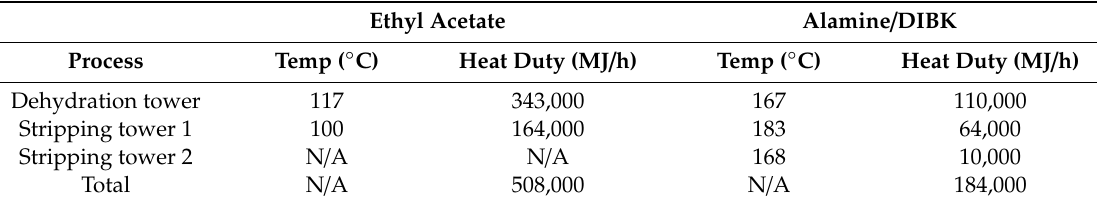
Table 2. Temperature and energy consumption for liquid–liquid extraction of acetic acid.